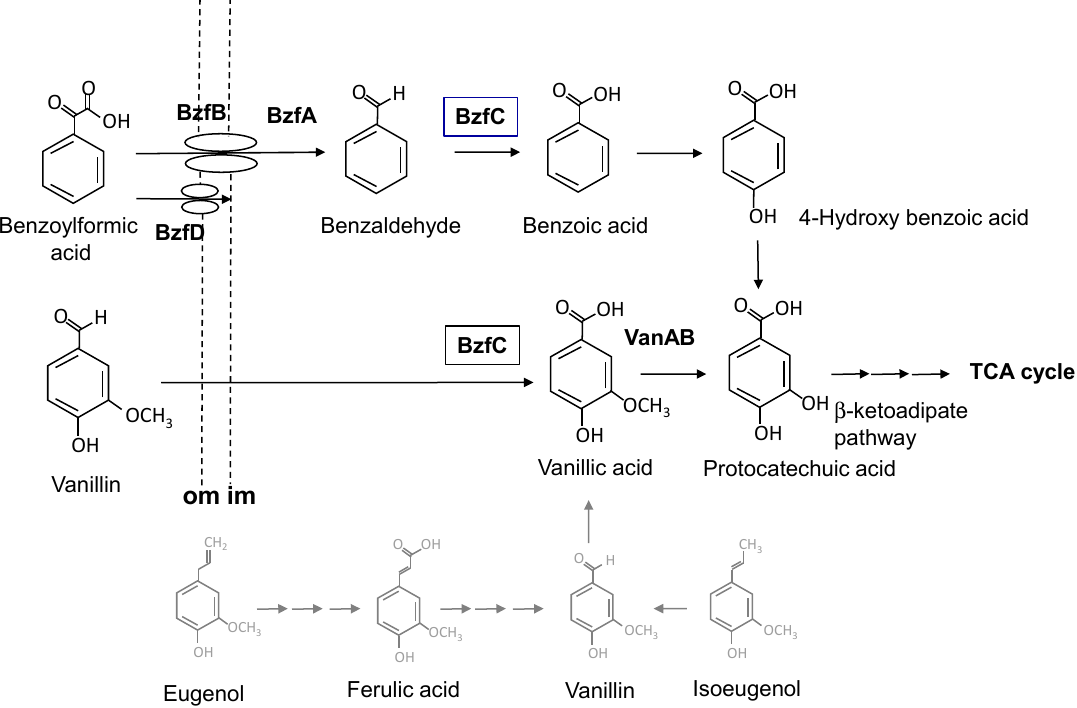
Figure 7. Putative metabolic pathways of benzoylformic acid and vanillin in strain LLC-1. Enzymes: BzfA, benzoylformate carboxylase; BzfC, benzaldehyde dehydrogenase/vanillin dehydrogenase; VanAB, vanillin- O -demethylase. Transporters: BzfB, BenK-like MFS transporter; BzfD, PhaK-like outer membrane porin. Structures: om, outer membrane; im, inner membrane. BzfC which convert both benzaldehyde and vanillin was highlighted within boxes. Catabolic pathways for eugenol, ferulic acid and isoeugenol of P. putida which are described in the 'Introduction' section, are represented in gray (Table S2).